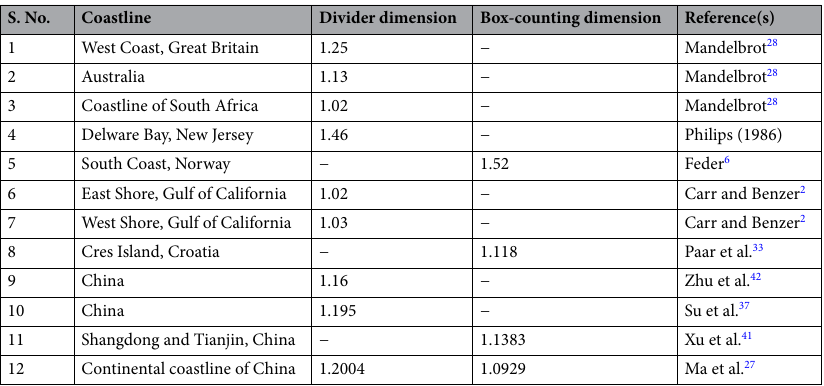
Table 2. Chronological calculations of fractal dimension ( D ) for various coastlines. “−”denotes no data available.